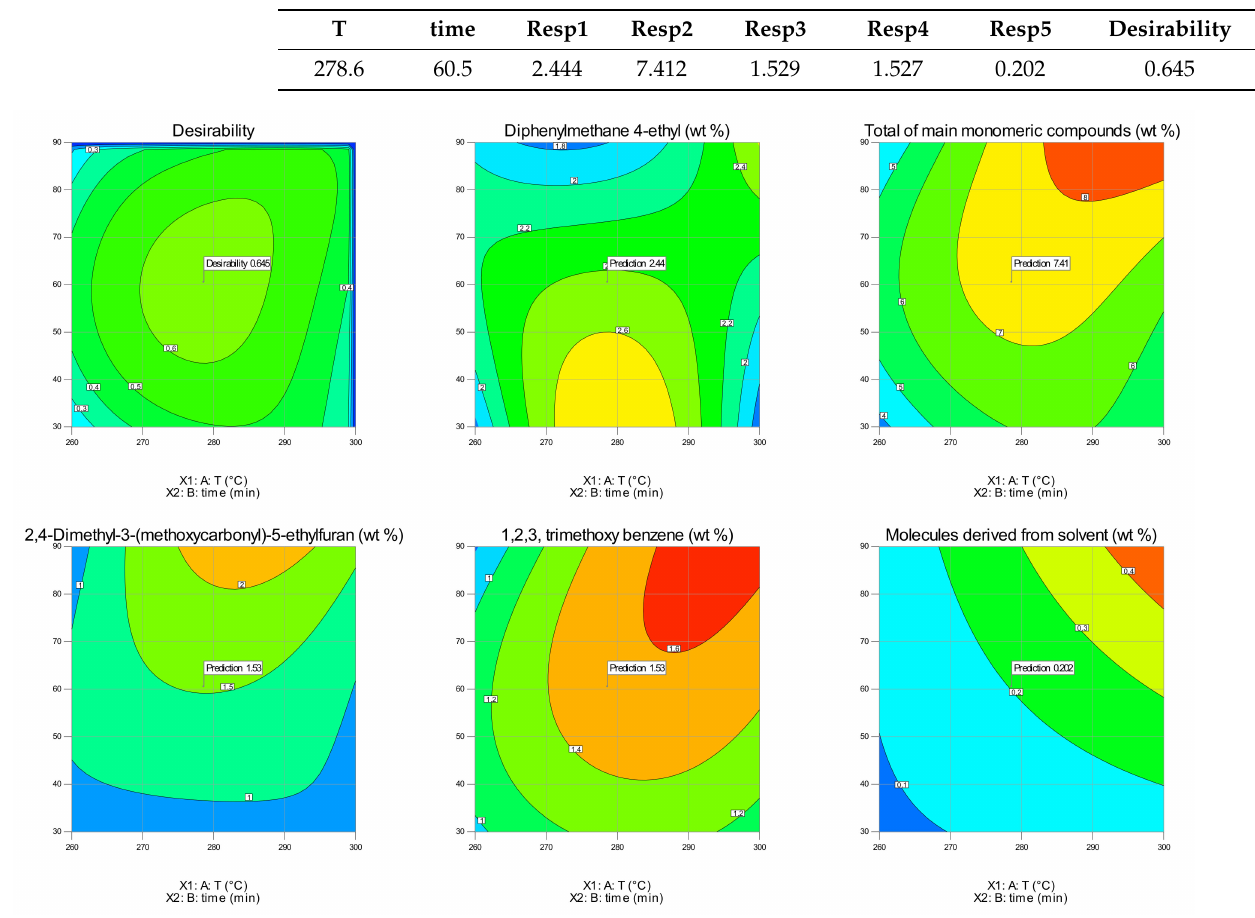
Table 3. Selected solution for the best operational condition.